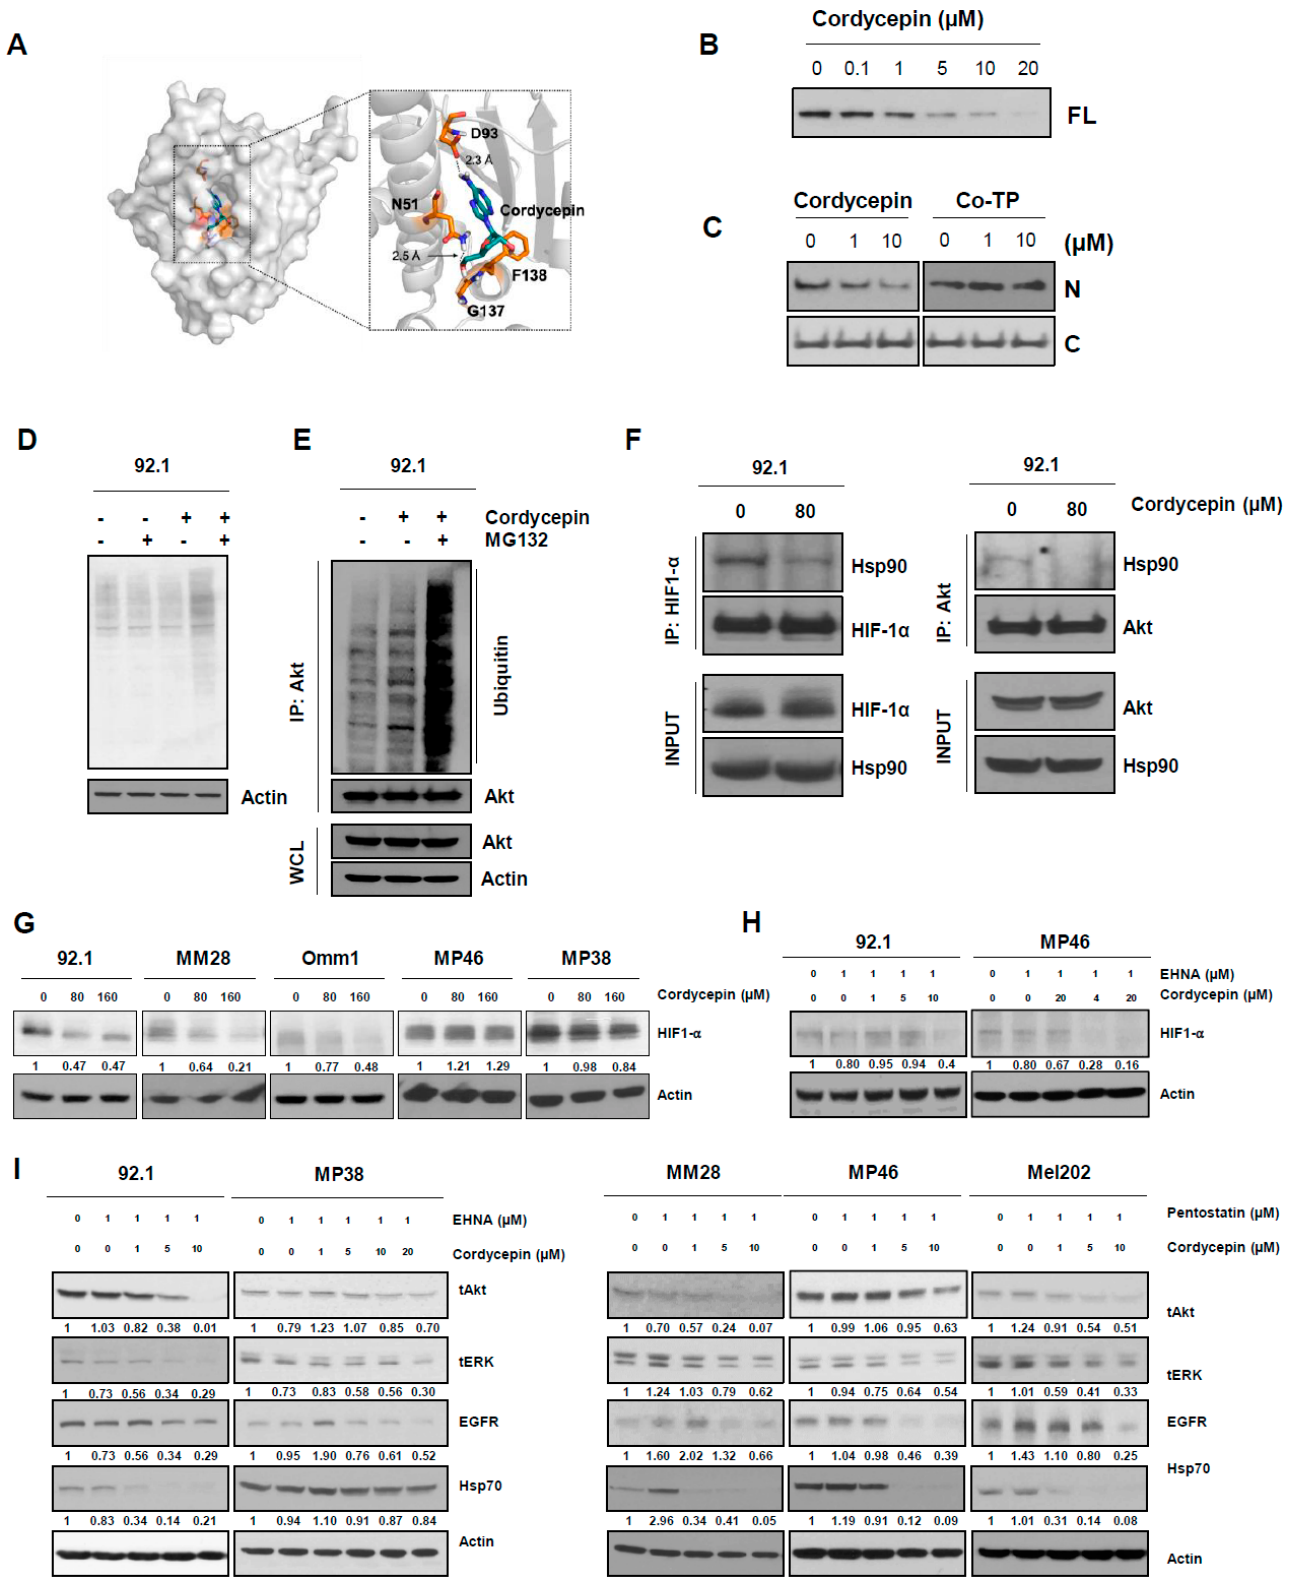
Figure 5. Cordycepin binds Hsp90 and disrupts its function, resulting in degradation of client proteins. ( A ) Visualization of possible interactions between the N-terminal of HSP90 (PDB: 6GPT) [52] and cordycepin within the HSP90 hydrophobic pocket (e.g., ATP binding site) observed by docking simulations. Non-polar hydrogens and amino acid residues apart from the key residues